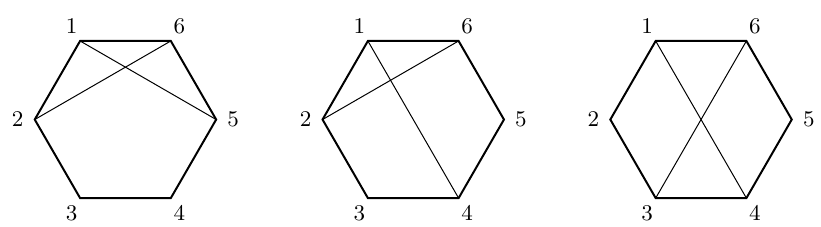
Figure 14. Forbidden pairs correspond to crossing chords of the